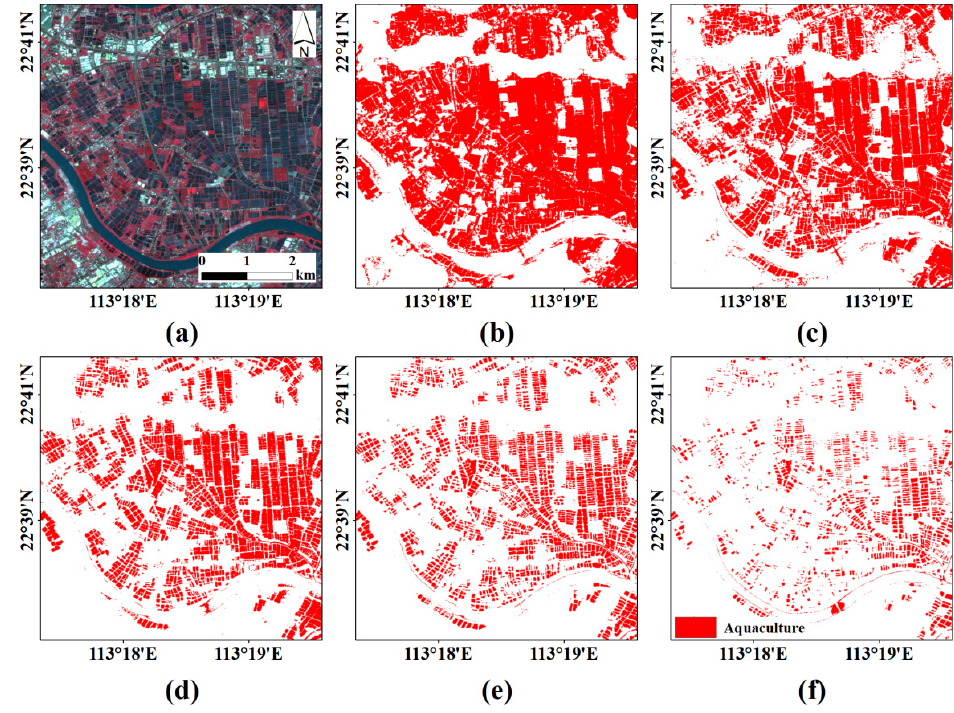
Figure 9. Typical classification maps using different thresholds: ( a ) Sentinel-2A MSI image, ( b ) T = − 0.2, ( c ) T = − 0.1, ( d ) T = 0, ( e ) T = 0.1, and ( f ) T = 0.2.